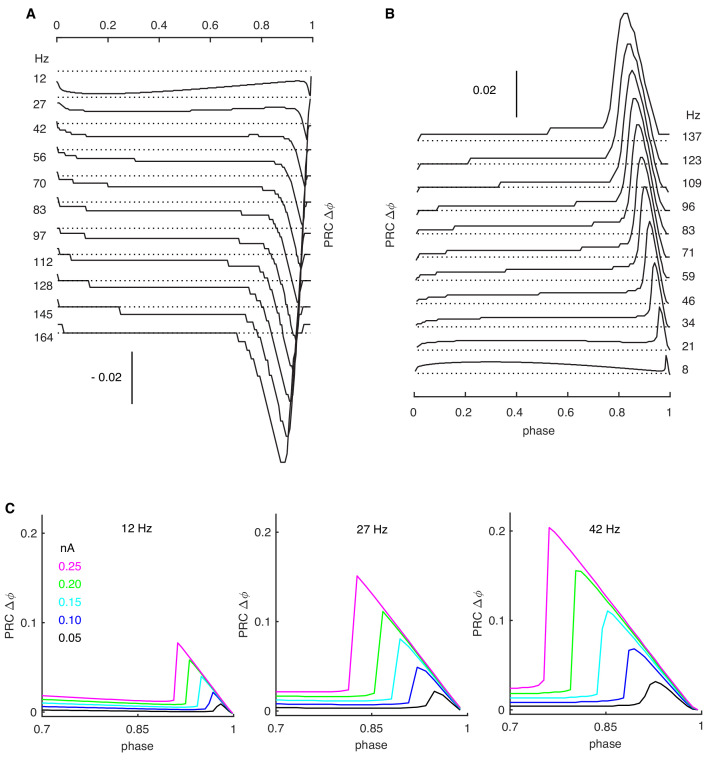
Rate-dependent PRCs.(A) Negative stimulus-triggered responses (phase delay) parallel positive stimuli (see Figure 1). Onset-phases of phase-dependent responses shift left at high rates with gradually larger amplitudes. (B) The PC model with passive dendrites shows similar rate adaptation as in PC models with active dendrites (Figure 1). (C) Larger stimulus amplitudes increase the peak of the phase-dependent PRCs and shift their onset phases to the left. Simulation results at rates of 12-, 27- and 42 Hz are shown with increased stimulus amplitudes from 0.05 nA to 0.25 nA.